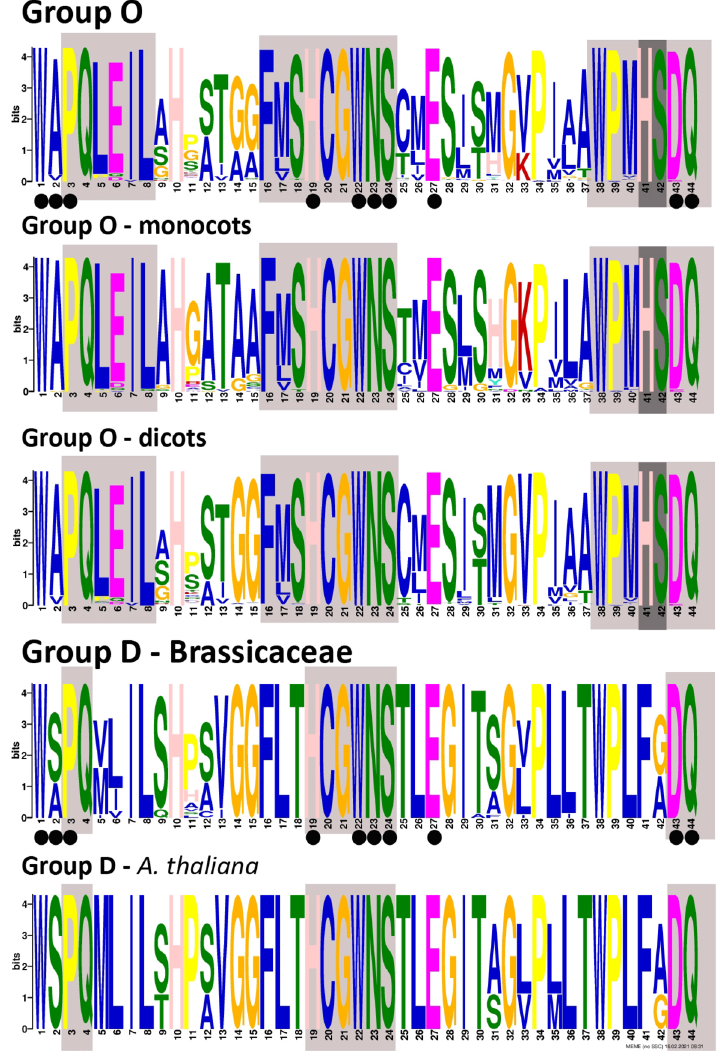
Figure 3. The conserved plant secondary product glycosyltransferase (PSPG) motif in group O in all taxa analyzed, monocots and eudicots in comparison with group D represented by Brassicaceae family. Highly conserved amino acids are shown in boxes (Group O: 1: 5 ′ -PQLEIL-3 ′ , 2: 5 ′ -FMSHCGWNS-3 ′ and 3: 5 ′ -WPMHSDQ-3 ′ ; group D: 1: 5 ′ -PQ-3 ′ , 2: 5 ′ -HCGWNS-3 ′ and 3: 5 ′ -DQ-3 ′ ). Group O— cis ZOG is characterized by 5 ′ -HS-3 ′ in the position 41 and 42 of PSPG. Circles indicate the residues interacting directly with the UDP-sugar based on available crystal structures according to Ref. 9